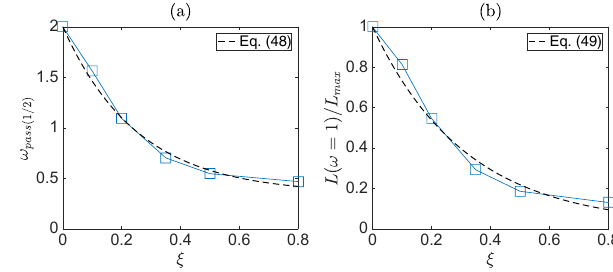
Figure 10. Dispersion relation, (cid:104) (cid:127)(k) (cid:105) with respect to different wavenumbers and (b) the maximum permissible frequency for dis- order parameters ξ = 0 . 0 , 0 . 1 , 0 . 2 , 0 . 35 , 0 . 5 and 0 . 8, with empirical quadratic fit given in the inset (ignoring ξ = 0 . 8).